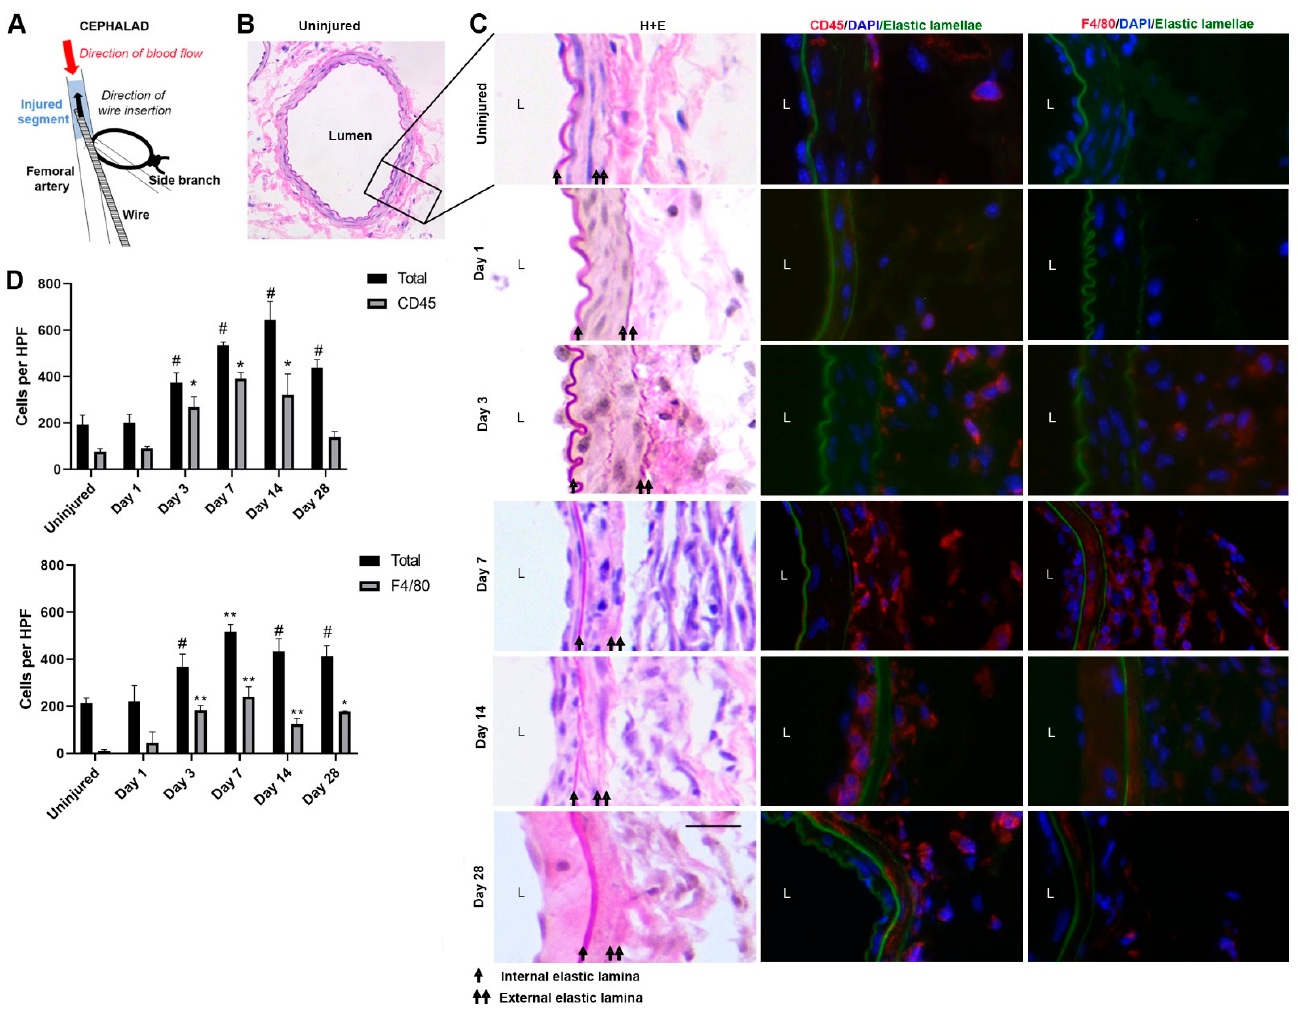
Figure 1. A. Schematic of mouse femoral artery wire injury model. ( A ) guidewire is inserted into the lumen of the artery through a muscular side branch and used to denude the endothelium and dilate the artery. Following removal of the wire, the branch is ligated, and the artery is reperfused. The injured segment is denoted in blue. ( B ) Representative hematoxylin and eosin (H + E) staining of the full cross-section of an uninjured artery. ( C ) Representative H + E and immunofluorescence for CD45 and F4/80 in uninjured (inset of B) and injured femoral artery cross sections 1, 3, 7, 14, and 28 days after injury. Internal and external lamellae are denoted by black arrows on H + E sections. “L” denotes arterial lumen. Red denotes CD45 or F4/80 staining. Green represents autofluorescence of the elastic lamellae. Original magnification 200×. Scale bar represents 5 μ M. ( D ) Quantification of CD45 + (gray bars in top plot) and F4/80 + cells (gray bars in bottom plot) by immunofluorescence at 1, 3, 7, 14, and 28 days after injury and in corresponding uninjured arteries from the same animals. Total cell number (black bars) was determined by DAPI-stained nuclei on the same sections. Each bar represents mean cells ± SEM in 4 high powered fields (HPF) from at least 3 different animals. At each time point, p values were calculated using the Mann–Whitney test and represent comparisons between stained cells or nuclei in the injured group with the uninjured group. # p = 0.04. * p = 0.03. ** p = 0.02 compared to uninjured group.